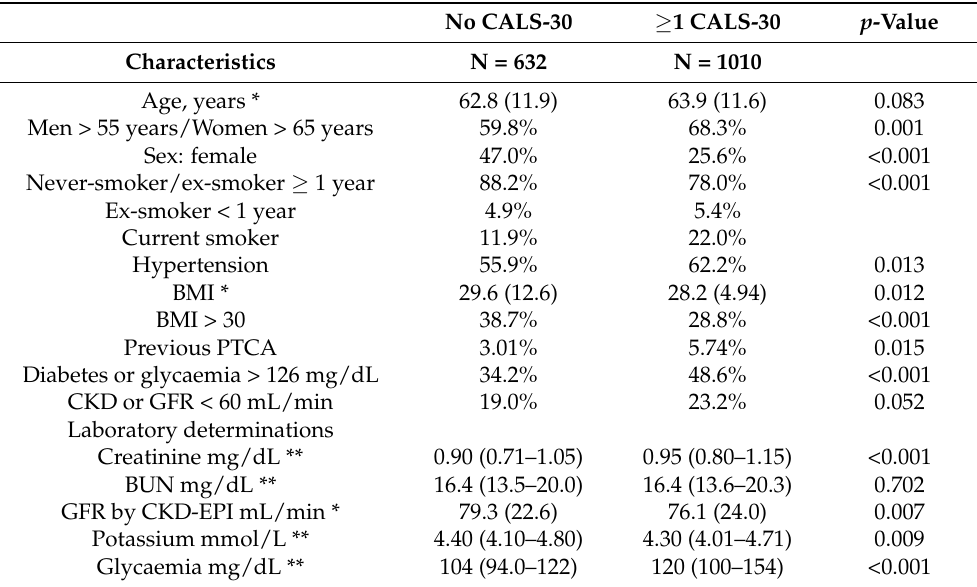
Table 1. Demographic and clinical characteristics of participants by the presence of coronary atherosclerotic lesions with ≥ 30% stenosis